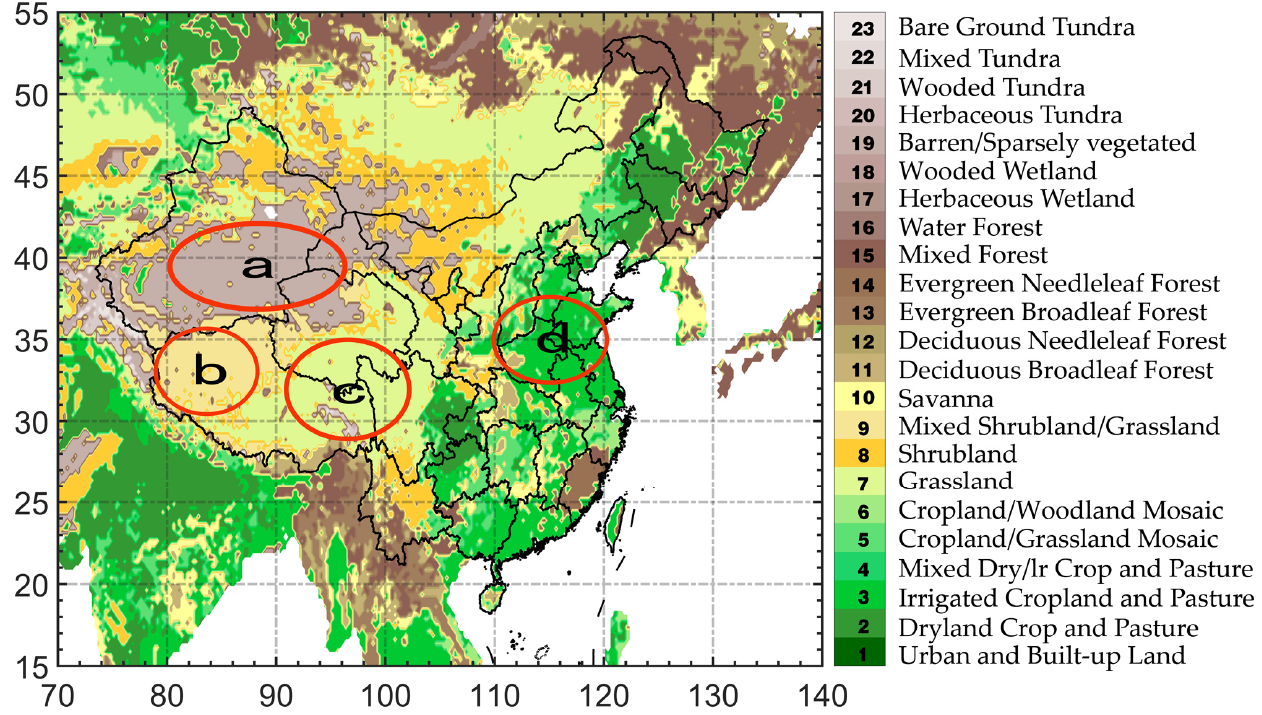
Figure 7. The four main underlying surface types in China selected for this study: ( a ) barren and sparse vegetation; ( b ) mixed shrubland and grassland; ( c ) grassland; and ( d ) irrigated cropland and pasture.